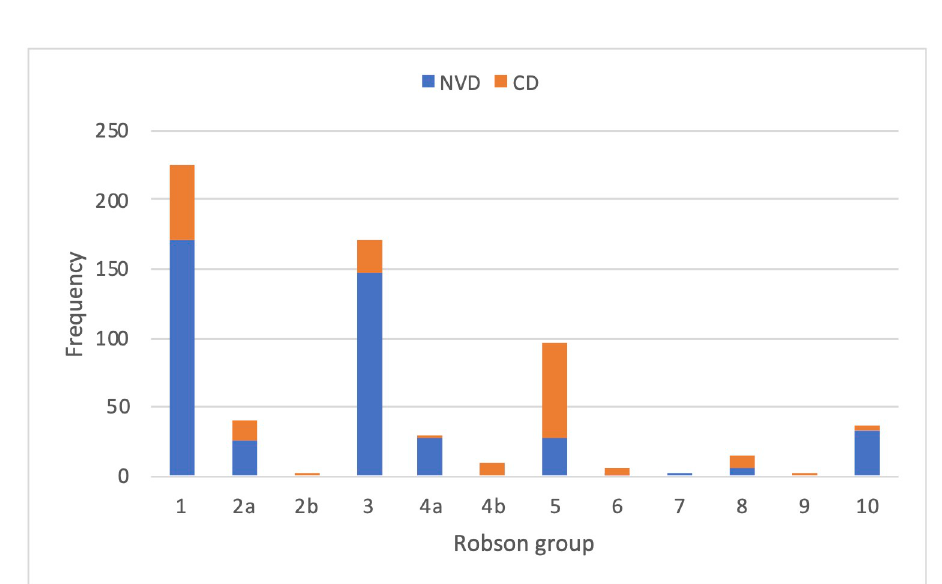
Fig 1. Mode of delivery counts according to Robson